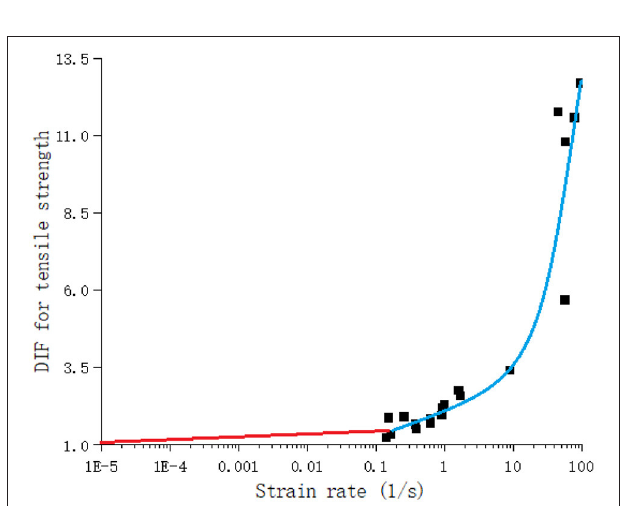
FIGURE 9 | Illustration of the failure mode of BFRAAC in spall test at strain rate of 56.8 s − 1 . FIGURE 10 | Tensile DIF of BFRAAC with respect to strain